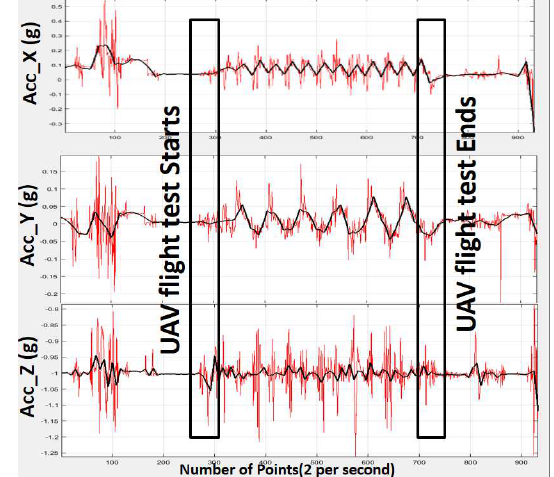
Figure 9. Acceleration graphs of data obtained during UAV flight test